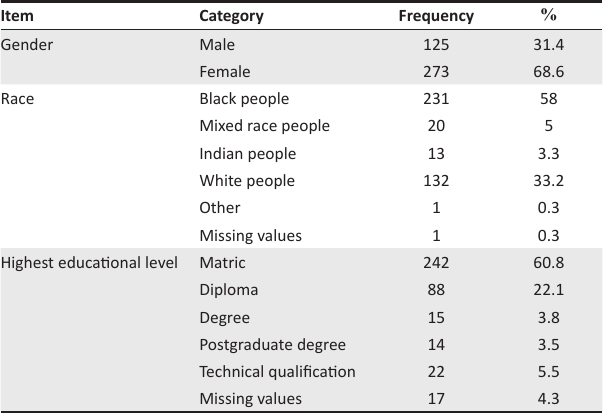
TABLE 1: Participant characteristics ( N =